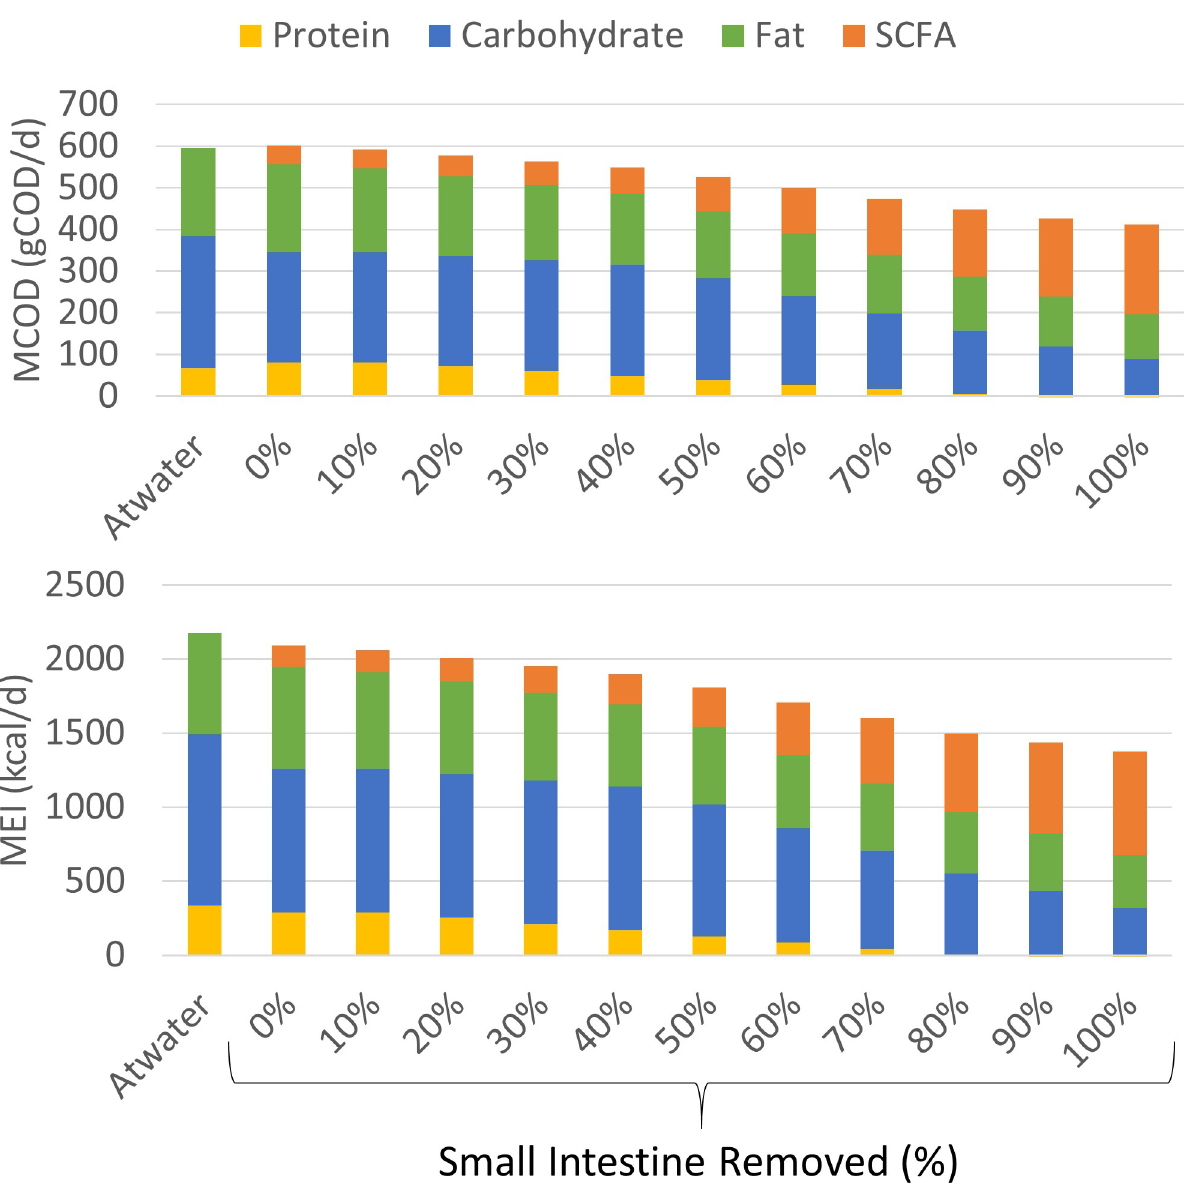
Fig 5. The effects of small intestine resection on the composition of a) COD and b) energy absorbed by the body. The calculations for the Atwater coefficients use typical metabolizable energy values listed in Table 1 and represents normal physiology. https://doi.org/10.1371/journal.pone.0253542.g005 PLOS ONE | https://doi.org/10.1371/journal.pone.0253542 July 28,